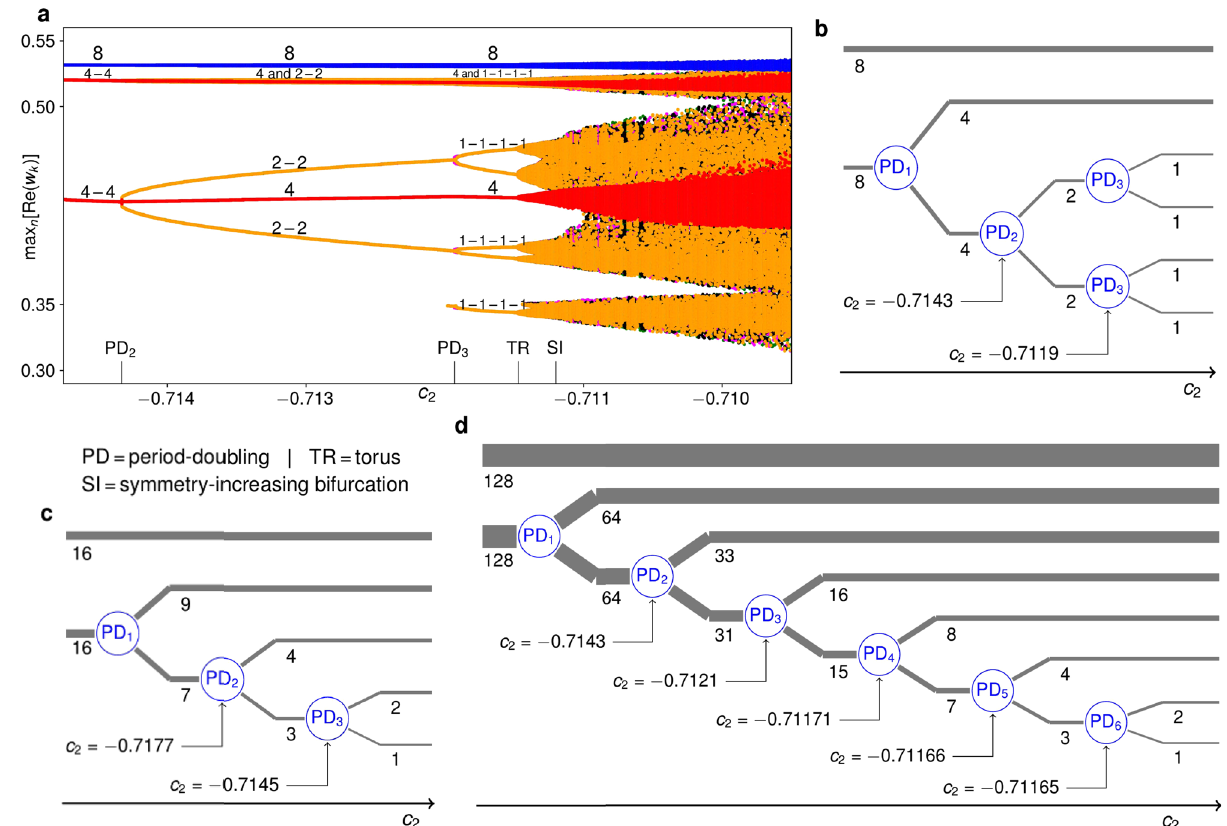
Fig. 3 Cluster-splitting cascades for different N . a Maxima of Re ð w k Þ in an N = 16 c 2 -incremented simulation at η = 0.63. Labels on the fi gure mark the clusters reaching the different maxima as the solution changes from 8 − 4 − 4 via 8 − 4 − 2 − 2 to 8 − 4 − (4 × 1). Labels on the abscissa mark occurring bifurcations. The additional smallest yellow maximum appearing at c 2 ≈ − 0.712 is caused by the continuous deformation of the oscillator trajectories and not by a bifurcation. At c 2 ≈ − 0.7115, the torus bifurcation to three-frequency dynamics manifests itself in a distinct broadening of the formerly discrete maxima. b Schematic portrayal of the period-doubling cluster splittings in the simulation in a . c , d Like b for c 2 -incremented simulations at η = 0.63 with N = 32 and N = 256, respectively, based on quantitative results shown in Supplementary Figs. 1 – 3 and described in Supplementary Note